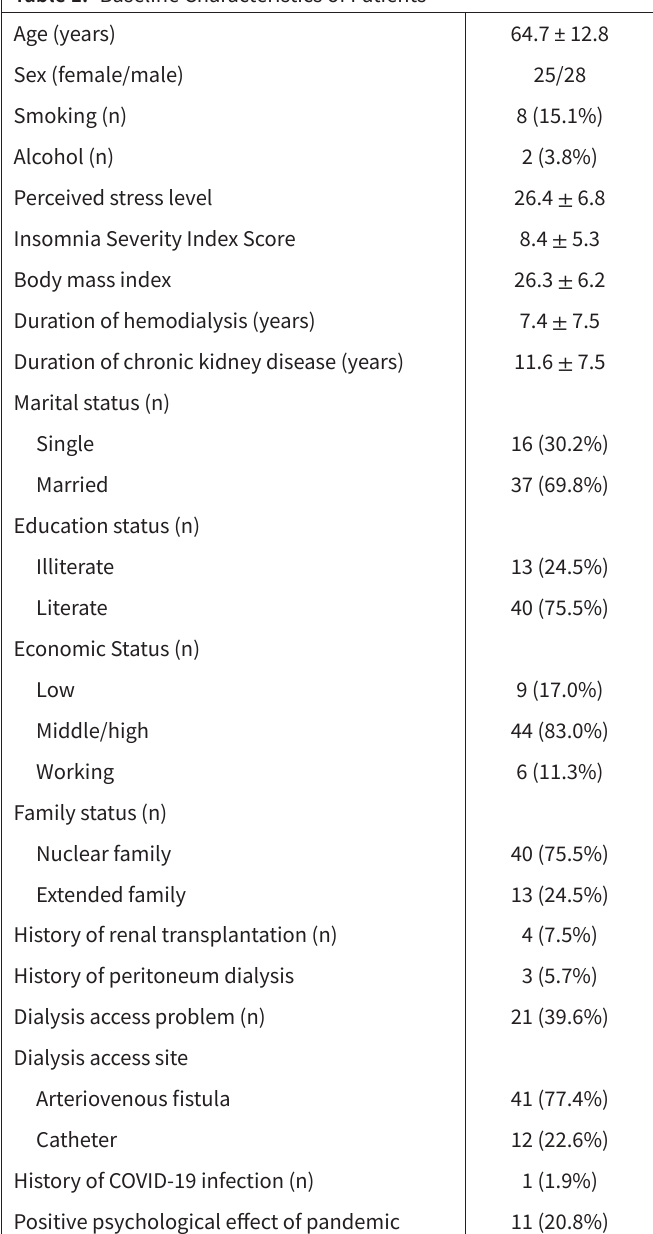
Table 1. Baseline Characteristics of Patients